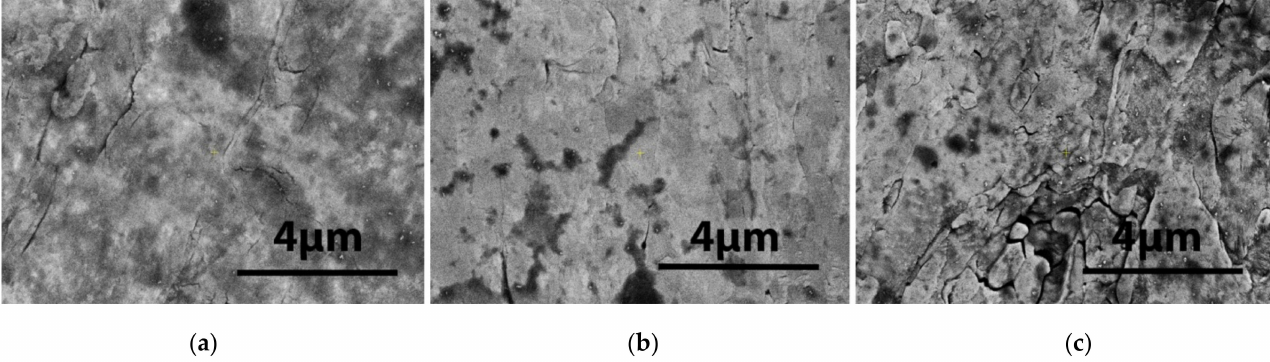
Figure 3. High-resolution images (at the similar magnification as in Figure 2 of the samples made of ( a ) W and ( b ) (W-K) 1 laminate and ( c ) (W-K) 2